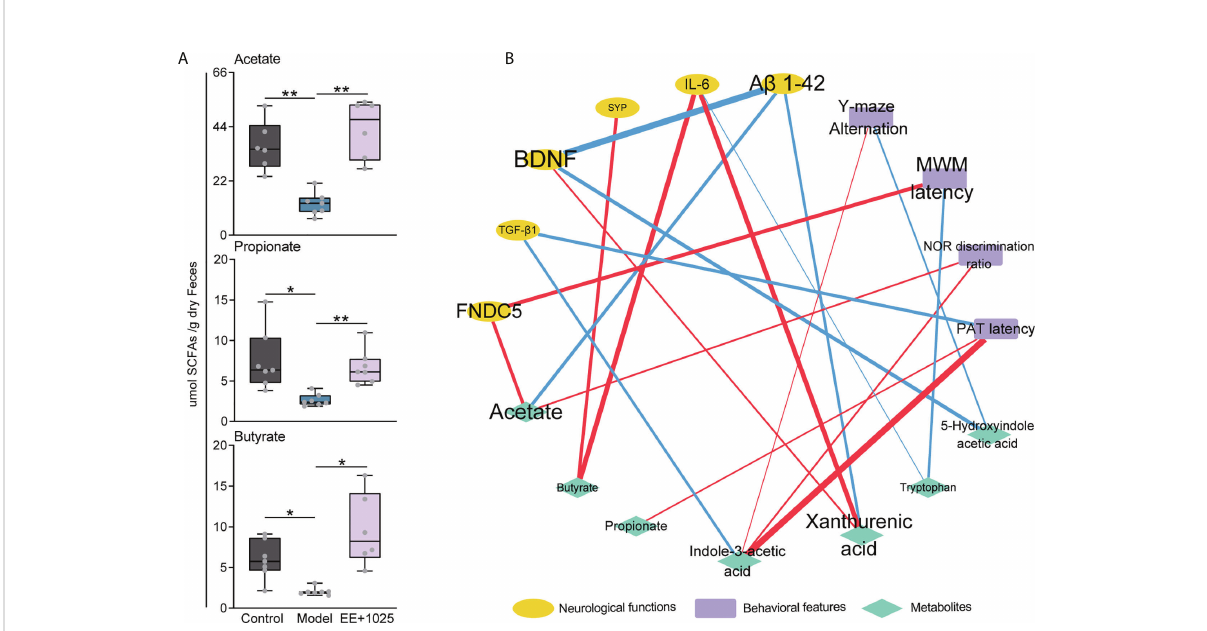
FIGURE 7 Integrated analysis reveals that brain function is associated with changes in microbial metabolites. (A) SCFA concentrations in feces. Data are presented as the median ± interquartile range. In the box plot, the bottom and top are, respectively, the 25th and 75th percentile, a line within the box marks the median. Whiskers above and below the box indicate 1.5 interquartile range of the lower and upper quartile, respectively. Each data point represents one independent mouse. * P < 0.05, ** P < 0.01 as determined by one-way ANOVA. (B) Spearman correlation network containing behavioral features, neurological data and metabolites. Red edges indicate a positive correlation and blue edges indicate a negative